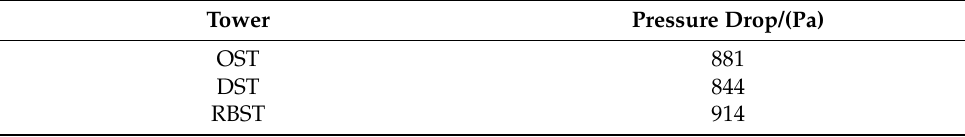
Table 7 lists inlet and outlet pressure drop data under three working conditions. The pressure drop of DST is 37 Pa lower than that of OST. In RBST, the rods are distributed across the entire cross section of the tower, which impedes the flow of the flue gas. As a result, the pressure drop is 33 Pa higher than the OST. Table 7. Pressure